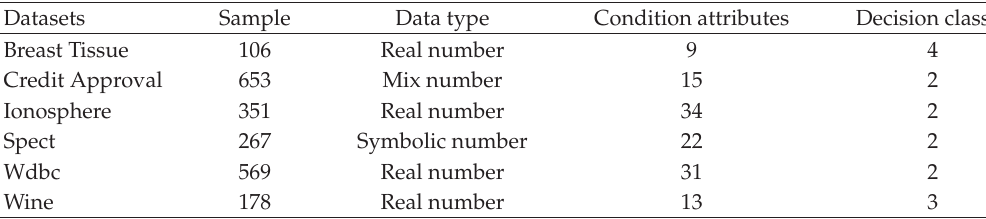
Table 3: Data sets